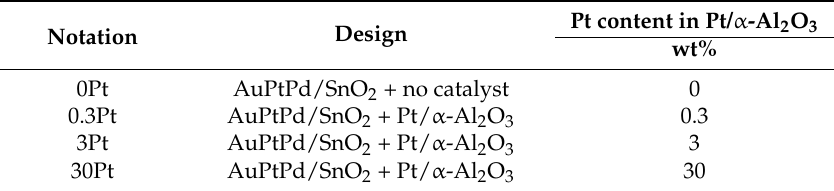
Figure 3. Double catalyst structures with AuPtPd/SnO 2 (A: Hot side) and 0.3–30 wt% Pt/ α -Al 2 O 3 (B: Cold side) catalysts for the micro-TGS: ( a ) No Pt catalyst; ( b ) 0.3 wt% Pt catalyst; ( c ) 3 wt% Pt catalyst, and ( d ) 30 wt% Pt catalyst. Table 1. Design of AuPtPd/SnO 2 and Pt/α-Al 2 O 3 double catalyst structures.